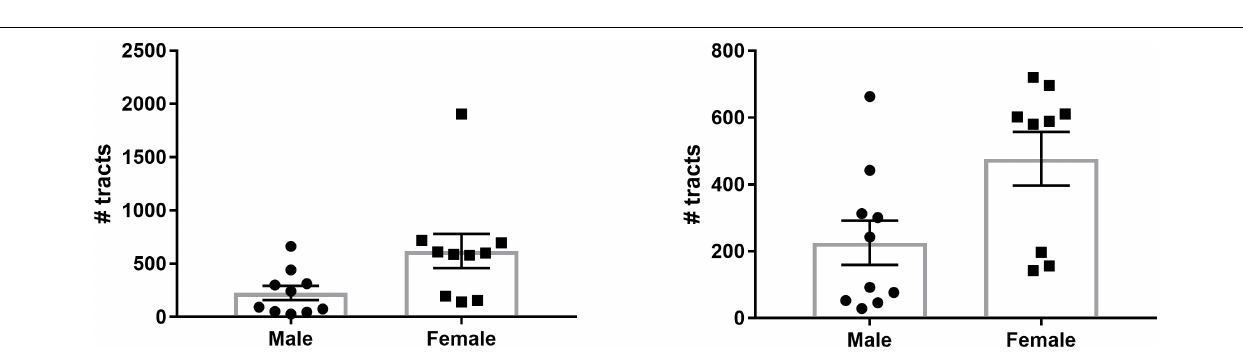
FIGURE 6 | Sex differences in LHb afferent/efferent streamline count. (Left) The number of streamlines for each subject as well as the group means are shown. There are a significantly greater number of LHb streamlines in female brains compared to male brains. (Right) Even with the outlier removed, the mean number of streamlines in females remains significantly greater than in